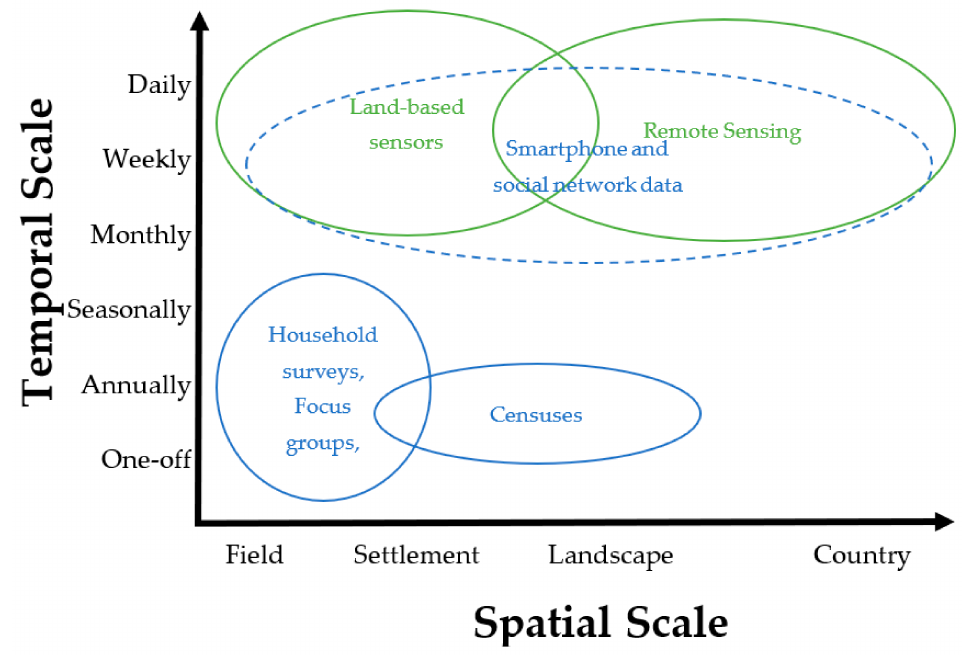
Figure 1. The disconnect between some common social (blue) and ecological (green) data collection methods across space and time. Smartphone and social network data (dashed blue) have the potential to bridge this